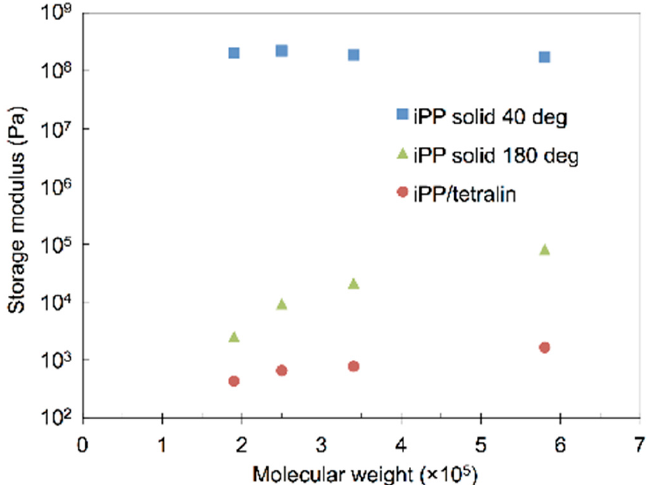
Figure 8. Storage modulus against molecular weights of iPP/tetralin5 at 40 ° C, iPP-solids at 40 ° C, and iPP-solids at 180 ° C.